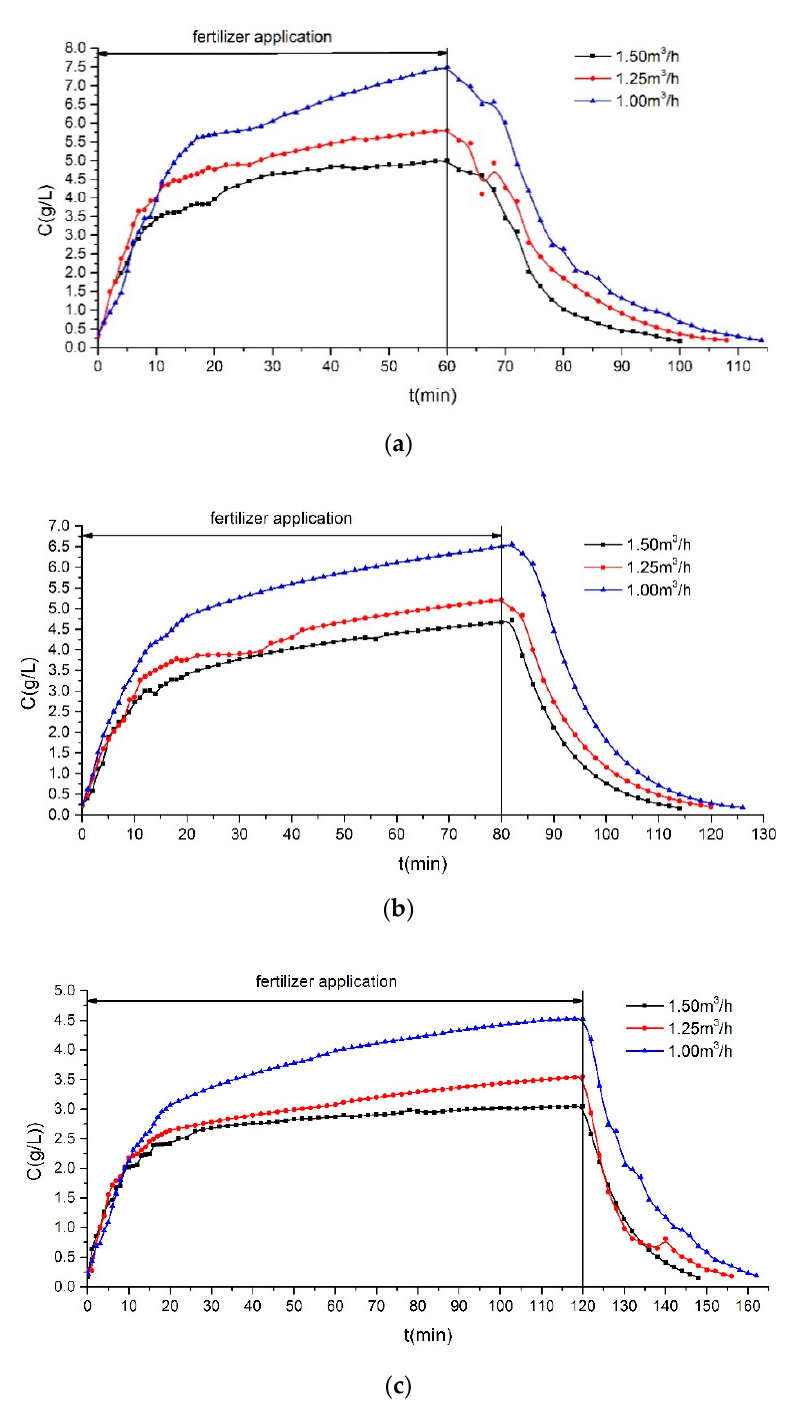
Figure 7. Variation of the fertilization concentration with time when the designed device applied 10 kg compound fertilizer. ( a ) T = 60 min, ( b ) T = 80 min, ( c ) T = 120 min.